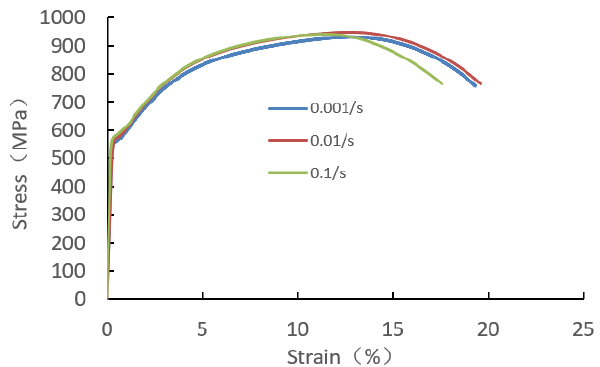
Figure 6. Real stress–strain curve of quenched and tempered 65Mn. Figure 6. Real stress – strain curve of quenched and tempered 65Mn. Figure 6. Real stress – strain curve of quenched and tempered 65Mn. Figure 6. Real stress – strain curve of quenched and tempered 65Mn.